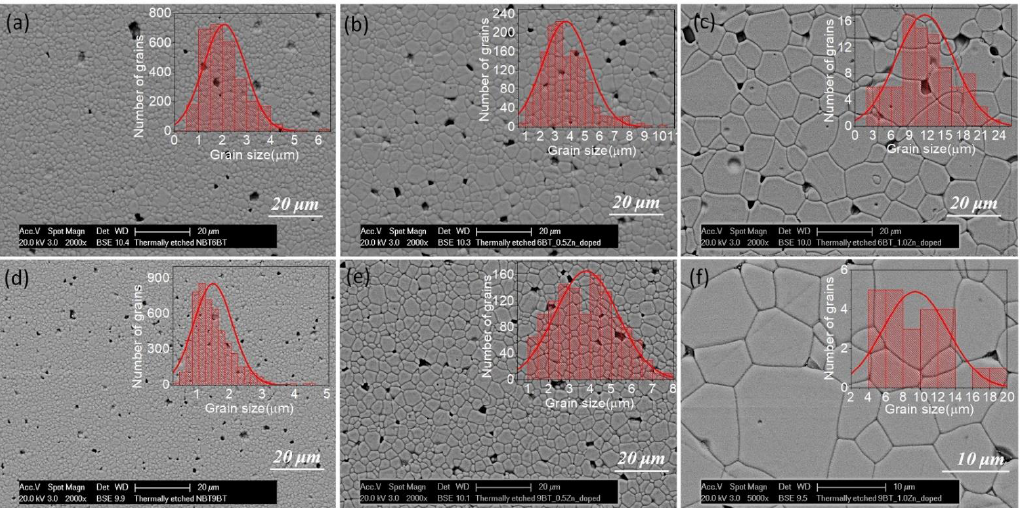
Figure 1. Scanning electron micrographs of thermally etched and polished surface of ( a ) NBT-6BT, ( b ) NBT-6BT-0.005Zn, ( c ) NBT-6BT-0.01Zn, ( d ) NBT-9BT, ( e ) NBT-9BT-0.005Zn and ( f ) NBT-9BT- 0.01Zn. The inset shows the corresponding grain size distribution.